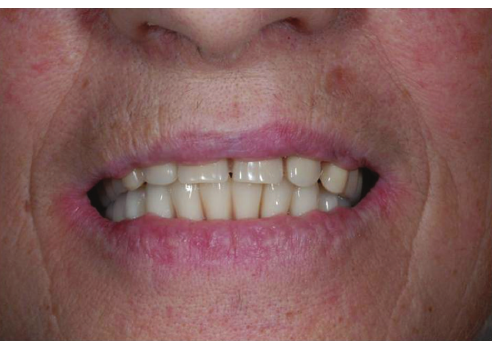
Figure 9: Titanium bar covered with pink opaque.